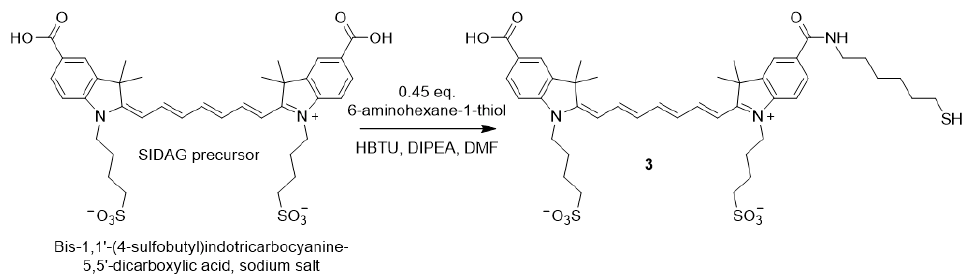
Figure A2. Cyanine derivative (SIDAG precursor [49]) and thiol-functionalized derivative 3 for coupling reactions via Michael addition.